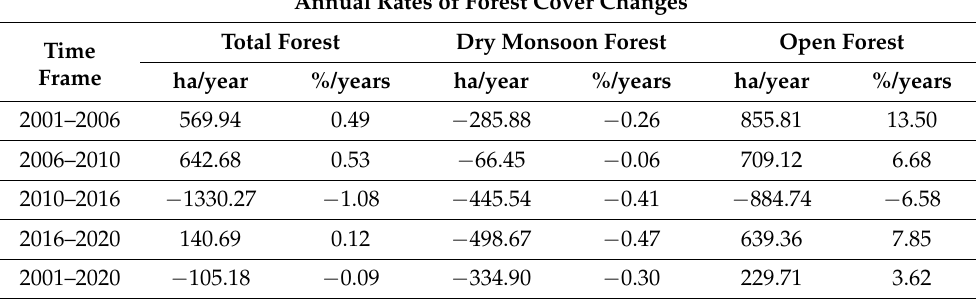
Table 4. Annual rate of forest cover